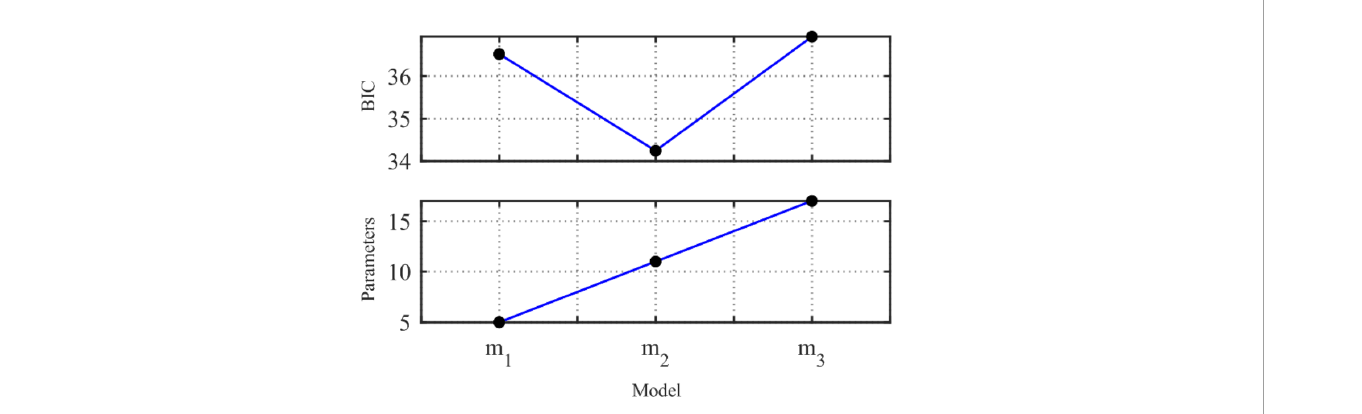
FIGURE 5 The result of model selection, the number of model parameters and the BIC